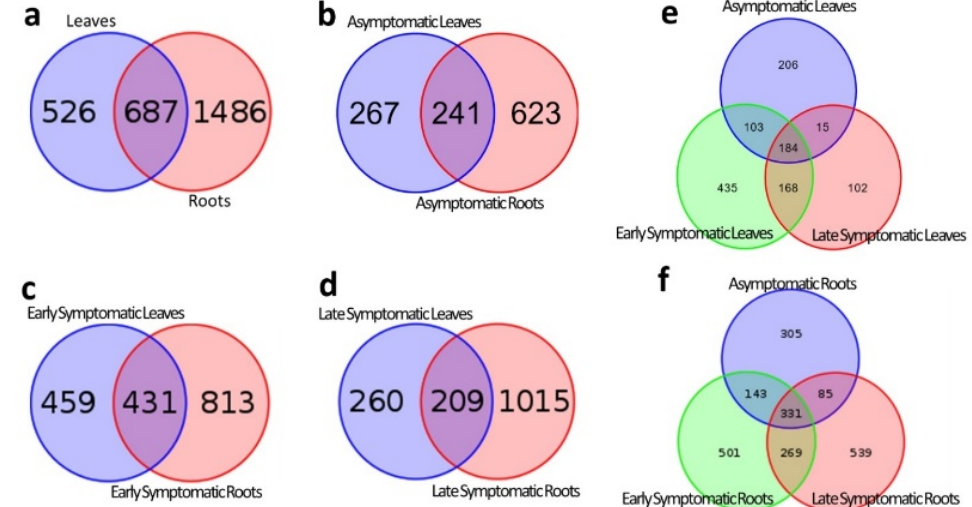
Figure 1. Graphs describing the different distribution of OTUs among different organs and/or sanitary statuses of examined plants: ( a ) Between all leaves and roots, regardless of sanitary status; ( b ) between leaves and roots of asymptomatic plants; ( c ) between leaves and roots of early symptomatic plants; ( d ) between leaves and roots of late symptomatic plants; ( e ) between the asymptomatic, early symptomatic, and late symptomatic plants at the leaves; ( f ) between the asymptomatic, early symptomatic, and late symptomatic plants at the roots.